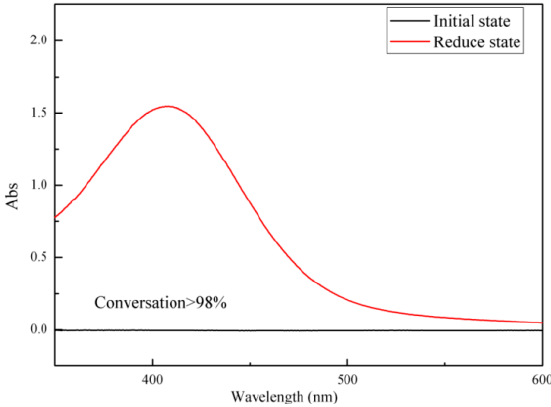
Figure 9. UV spectra of nanogels in the initial state and the reduced state.